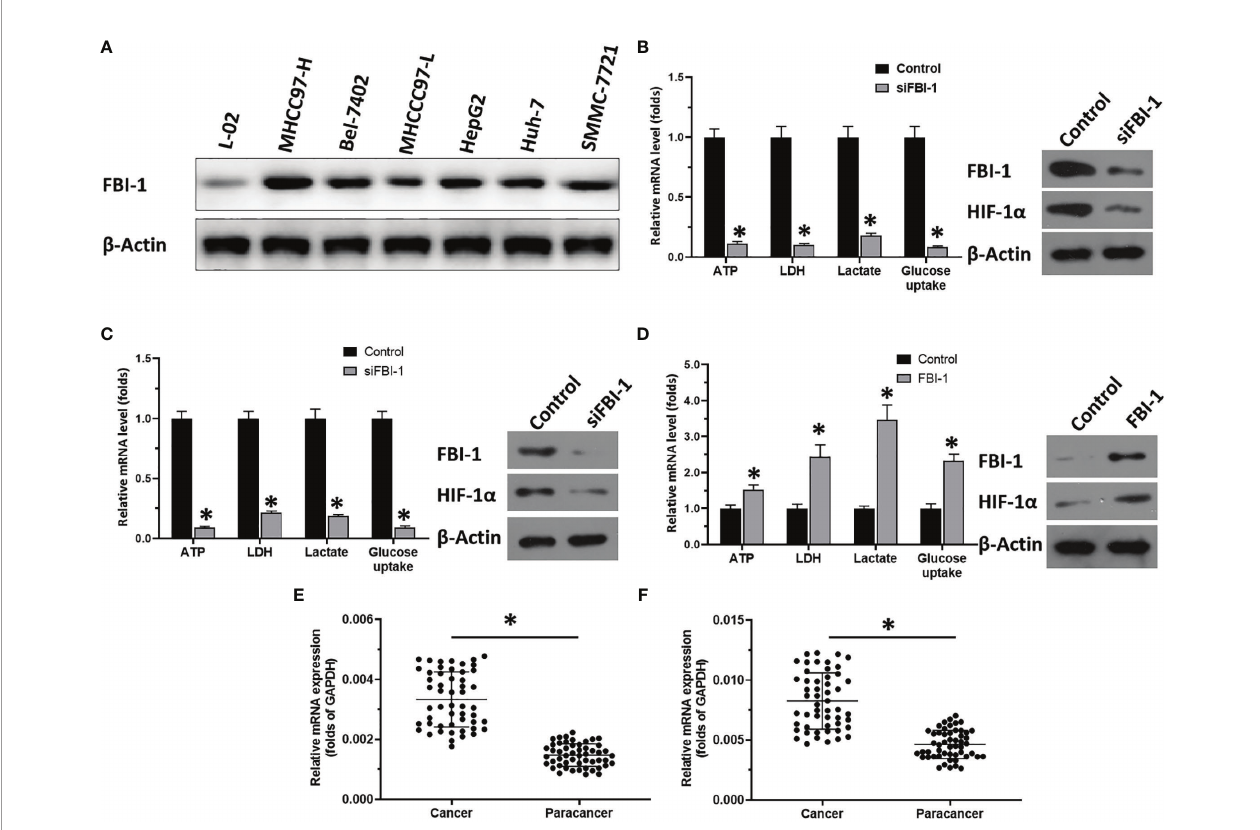
FIGURE 1 | FBI-1 promotes the Warburg effect of HCC cells. (A) The endogenous protein level of FBI-1 in hepatic cells. (B – D) The effect of FBI-1 on HCC cells ’ Warburg effect. (E, F) The expression of FBI-1 or HIF-1 a . *p < 0.05 versus with control group or siFBI-1 groups (B – D) ; *p < 0.05 (E, F)